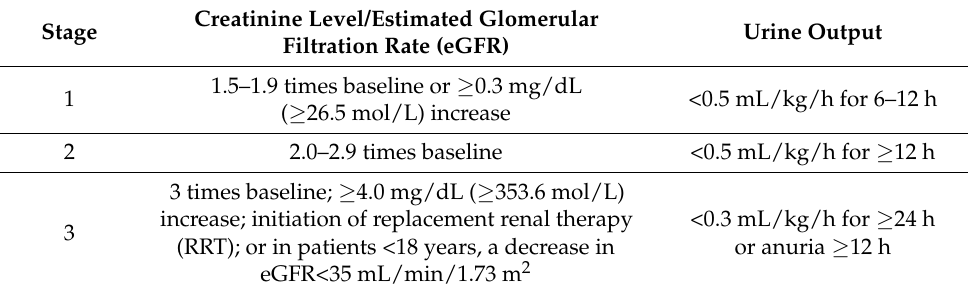
Table 1. Staging of AKI according to the Kidney Disease Improving Global Guidelines